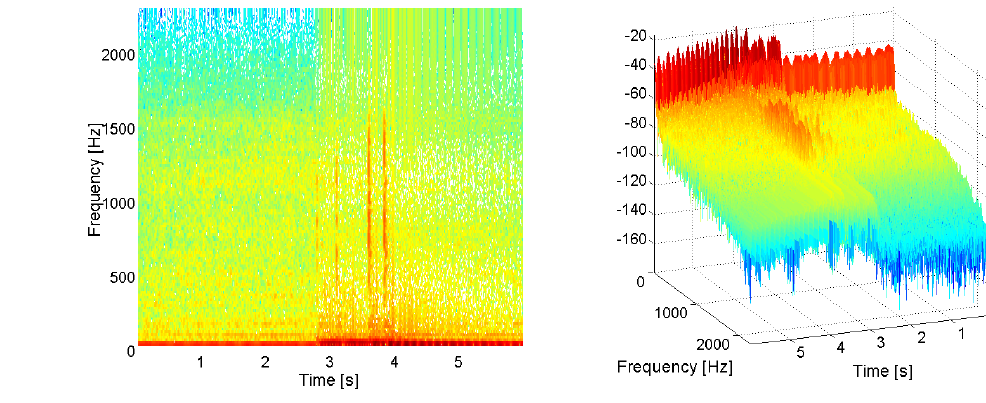
Fig. 32. 2D spectrogram of acceleration signal. Fig. 33, 3D spectrogram of acceleration